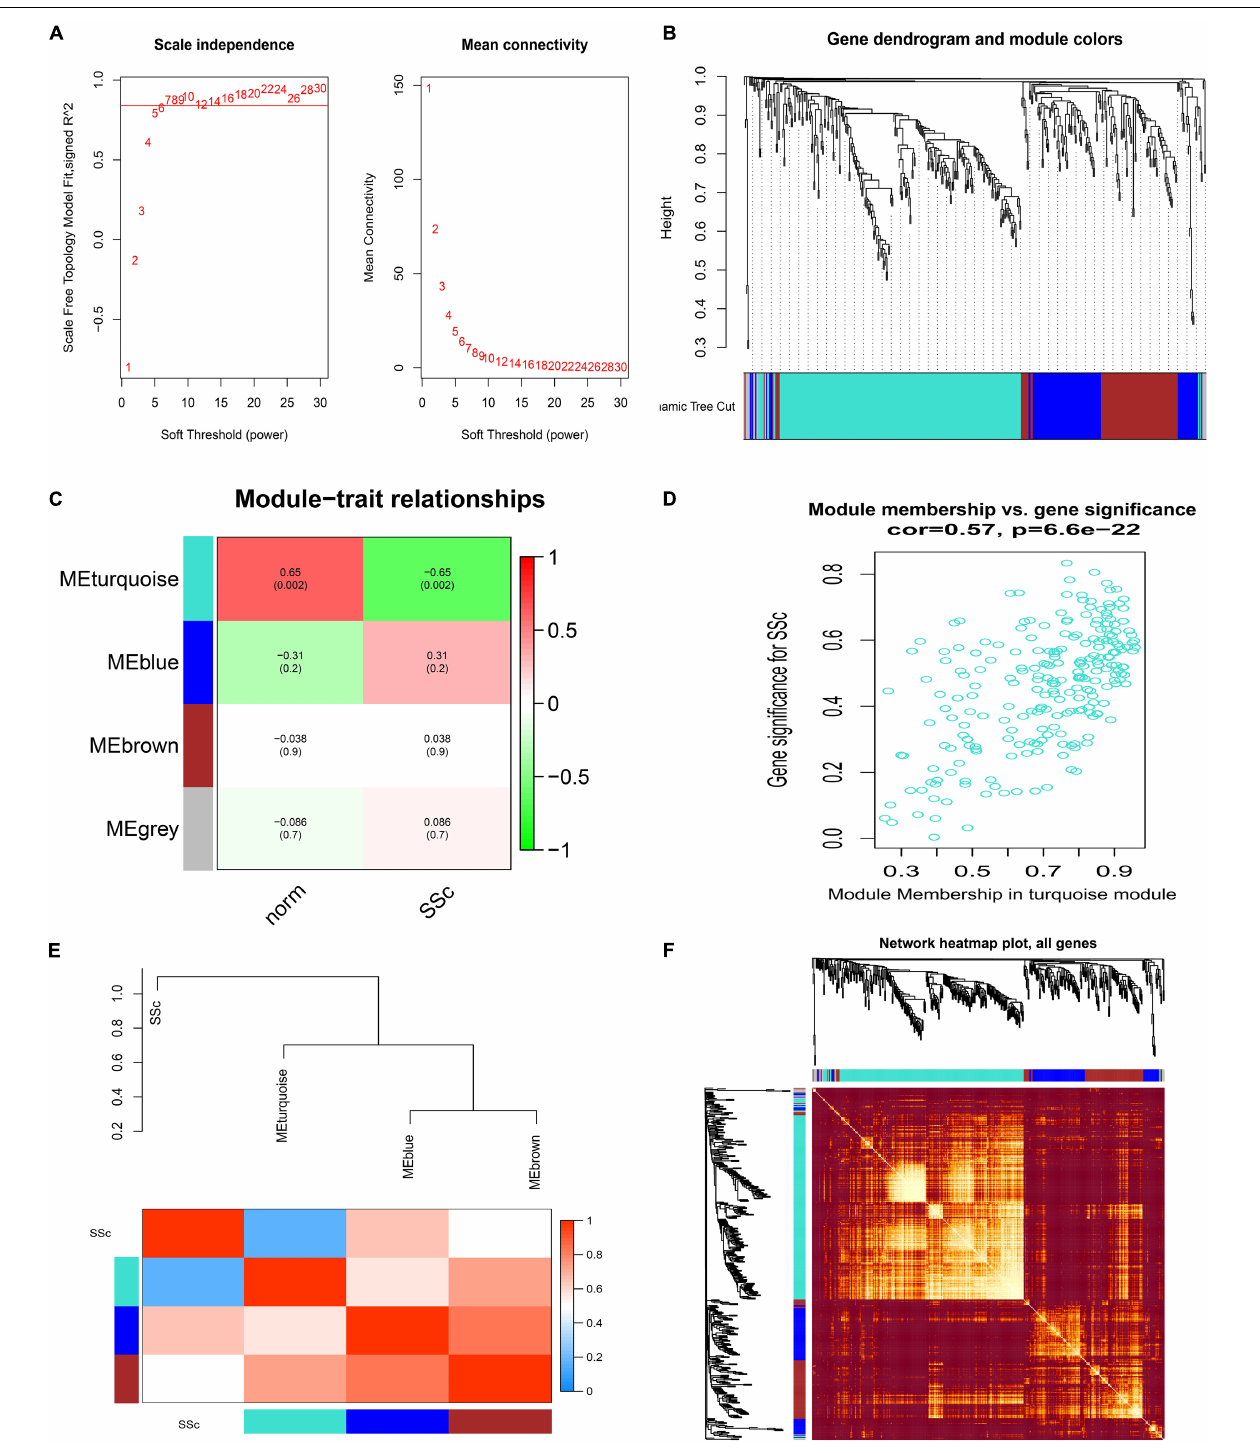
FIGURE 5 | Construction of weighted gene co-expression network of GSE81293. (A) Analysis of the scale-free topology model fit index for soft threshold powers ( β ) and the mean connectivity for soft threshold powers. (B) Cluster dendrogram of the co-expression network modules was produced based on topological overlap in the miRNAs. Each branch means one miRNA. Each color means one co-expressed module. (C) Heatmap of the correlation between module eigengenes and clinical traits. (D) Scatter plot of module eigengenes in the turquoise module. (E) Dendrogram and unsupervised hierarchical clustering heatmap of module eigengenes and SSc. (F) Interactive relationship analysis of co-expression miRNAs. The light color indicates topological overlap, while the darker color indicates a high topological overlap. SSc, systemic sclerosis.